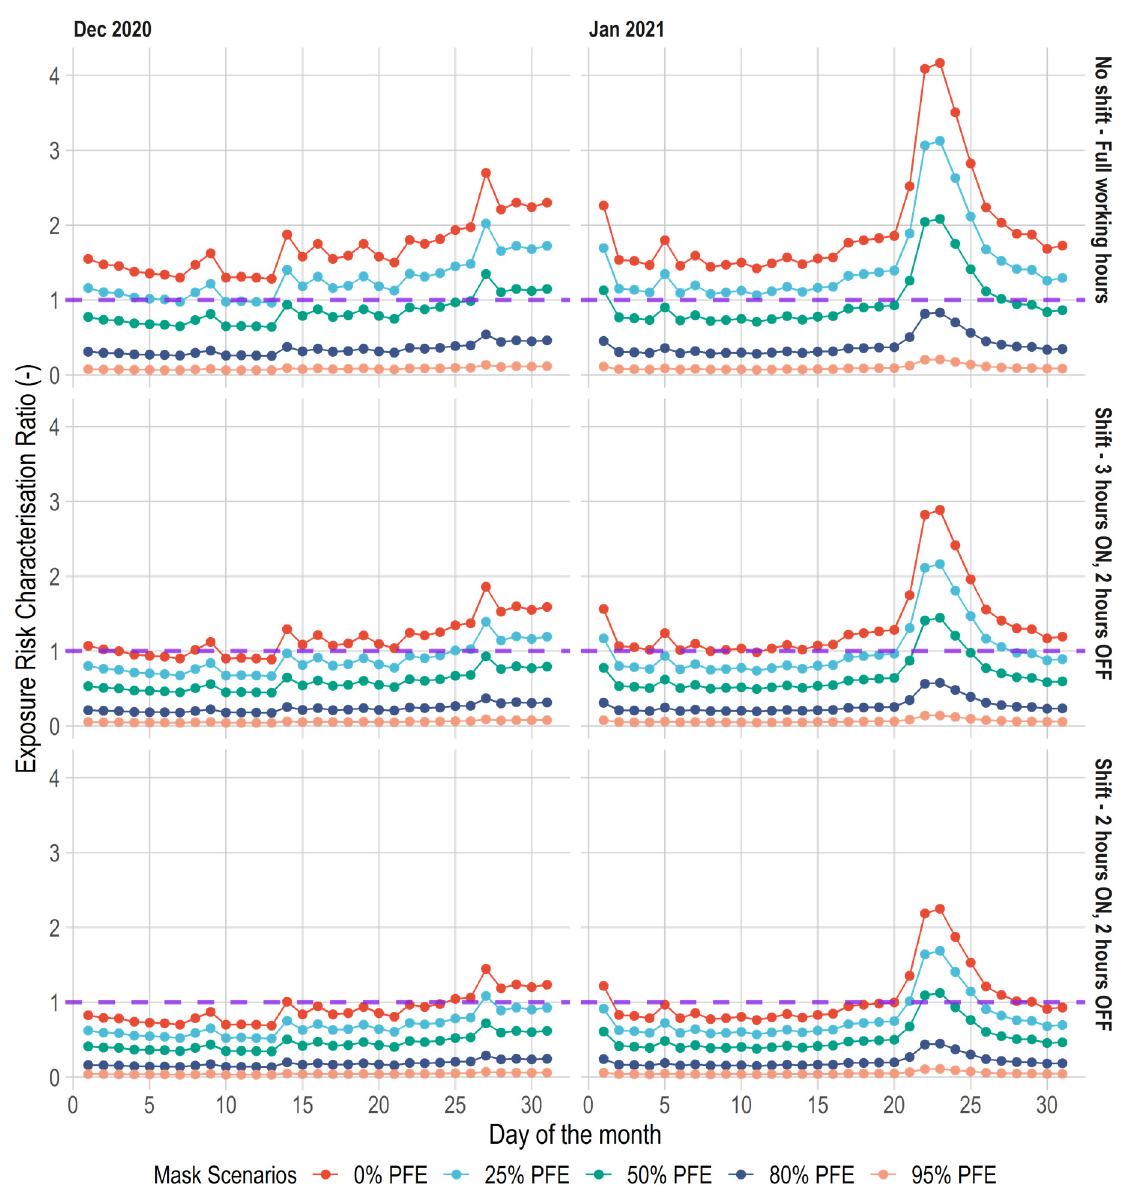
Figure 7. Influence of control interventions on daily occupational exposure risk.